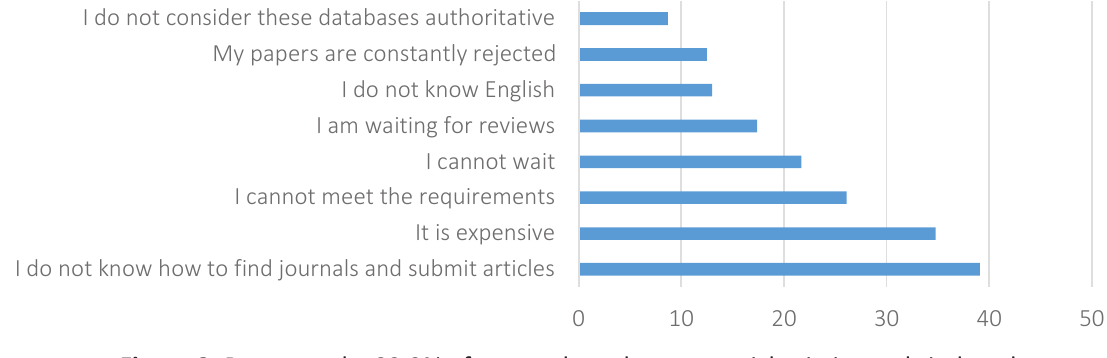
Figure 3. Reasons why 32.9% of respondents have no articles in journals indexed in Web of Science and (or)